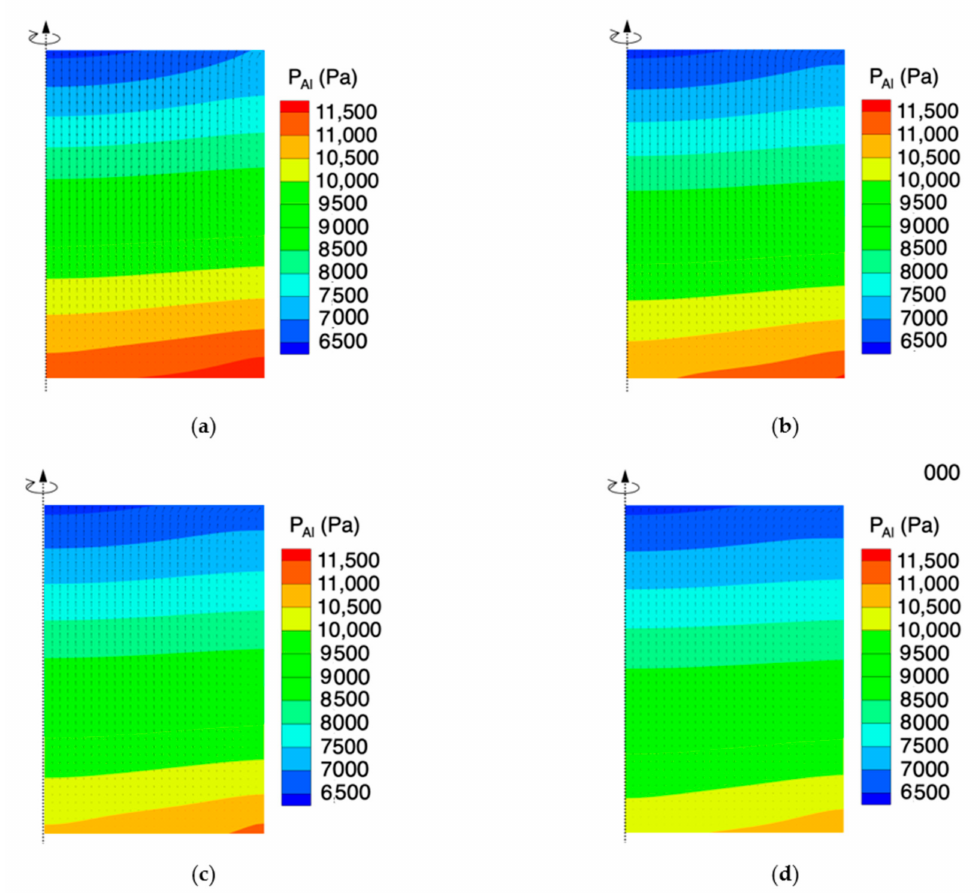
Figure 4. Distribution of mixed flow and Al vapor partial pressure in the growth chamber at porosities of ( a ) 0.4, ( b ) 0.3, ( c ) 0.2, and ( d )